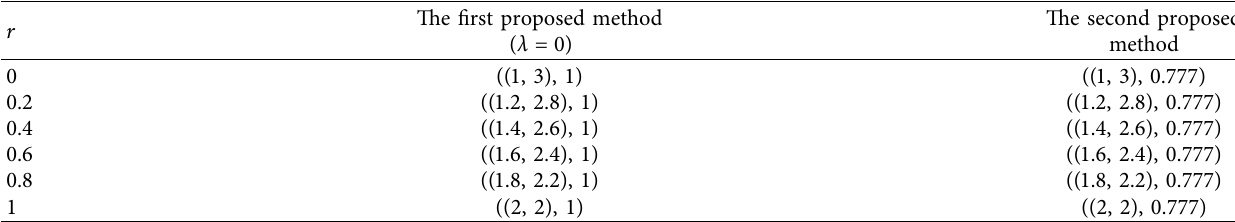
( r ) result using the two proposed methods ( λ � 0 ) . 2